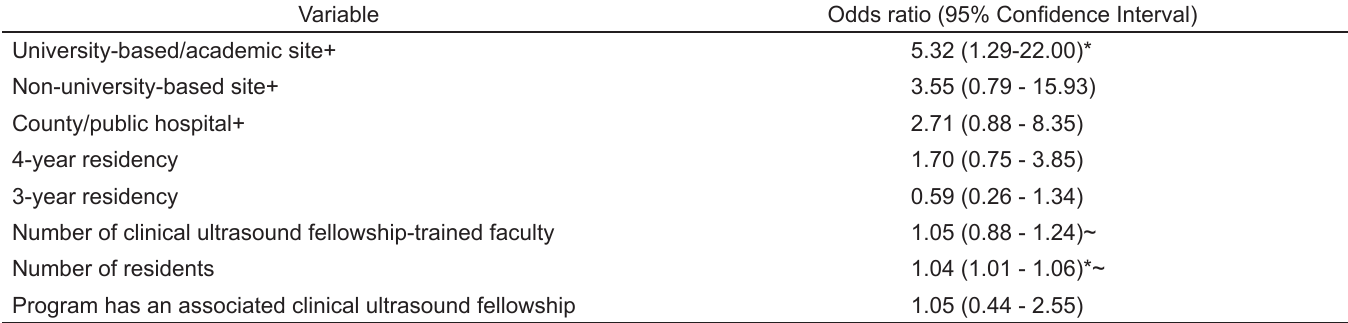
Table 3. Reasons provided for residency programs not having a point-of-care ultrasound scholarly track (n = 142).